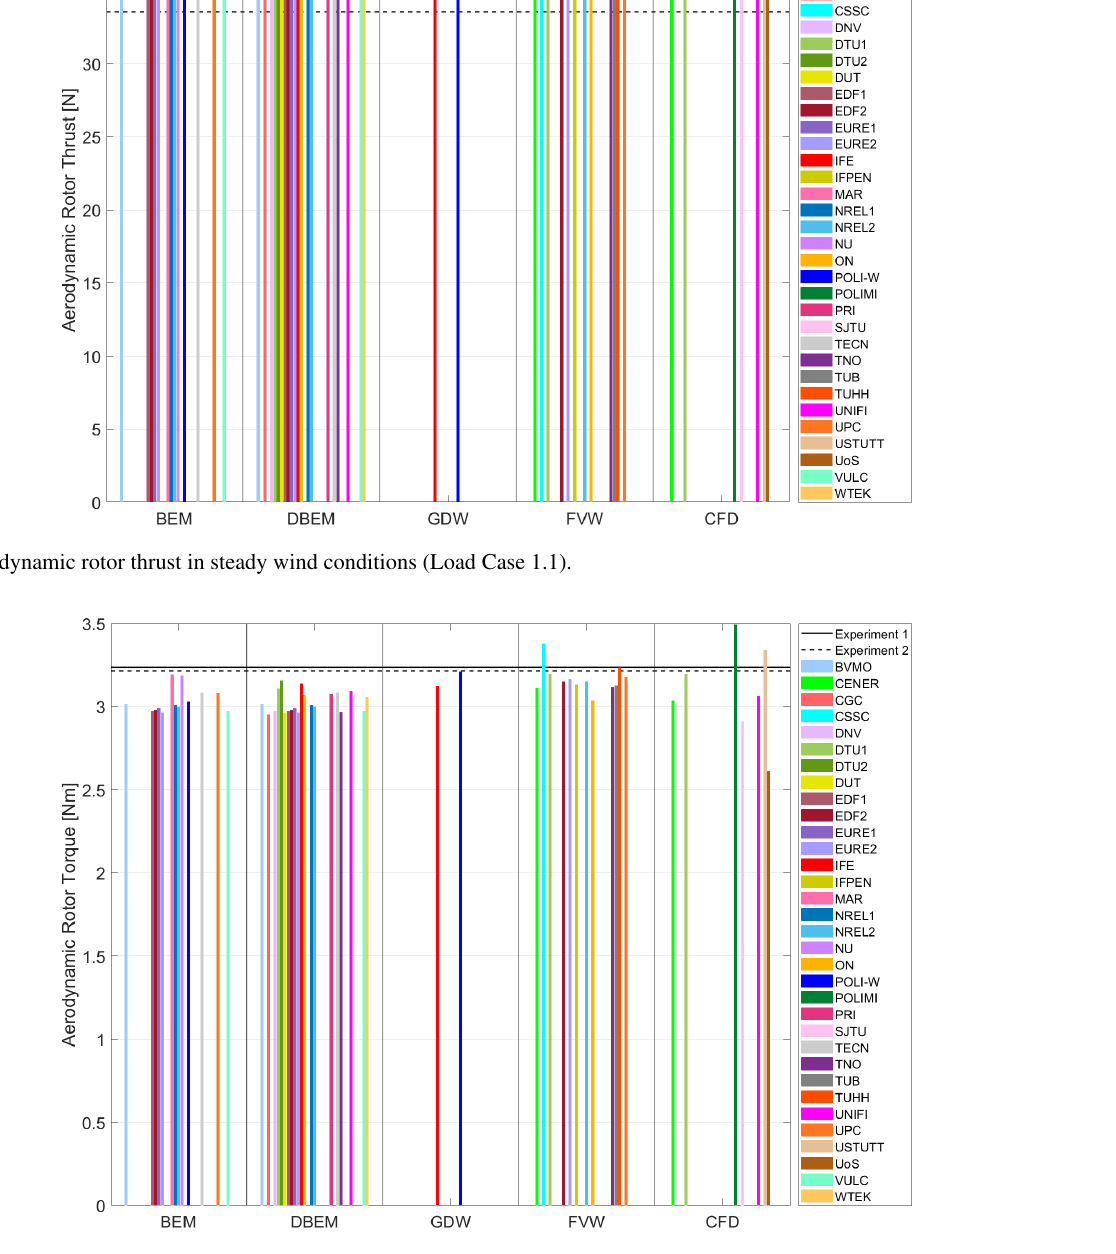
Figure 4. Aerodynamic rotor torque in steady wind conditions (Load Case